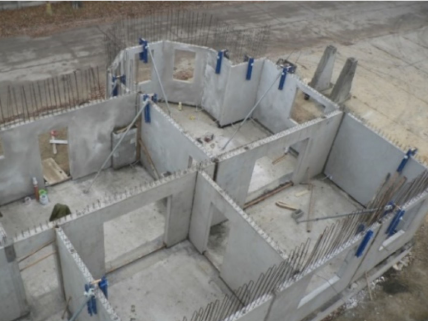
Figure 21. Completion of the ground floor assembly. (Photo archive: Kal ú s, D.) [13].